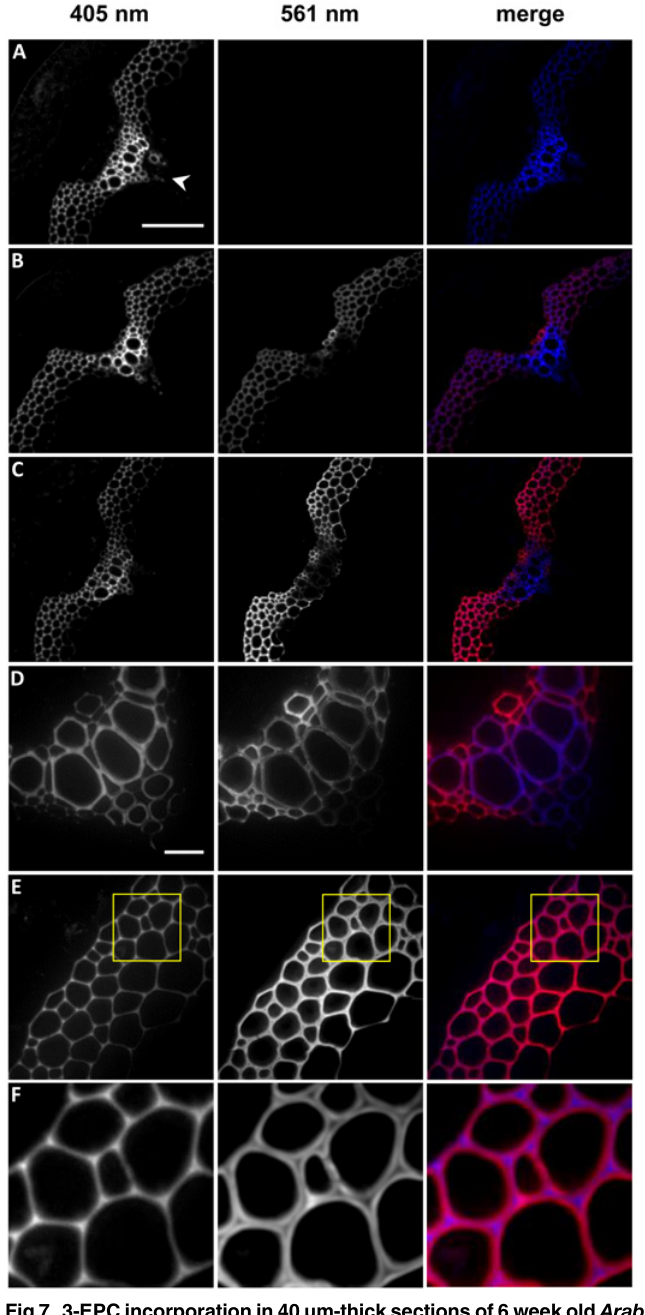
Fig 7. 3-EPC incorporation in 40 μ m-thick sections of 6 week old Arabidopsis stems. Autofluorescence (405 nm excitation) and click labeling (561 nm excitation) in (A) control section treated with 20 μ M CA for 3 h, labeled with Alexa-594 azide for 1 h, and washed with 96% ethanol for 1 h; (B) section treated with 20 μ M 3-EPC and 20 μ M CA for 3 h, labeled with Alexa-594 azide for 1 h, and washed with 96% ethanol for 1 h; and (C) section treated with 20 μ M 3-EPC for 3 h, labeled with Alexa-594 azide for 1 h, and washed with 96% ethanol for 1 h. (D) Xylem and (E) interfascicular fibers (IFFs) of section treated with 20 μ M 3-EPC. (F) Zoomed-in region from image in (E), indicted by yellow box, showing incorporation patterns of 3-EPC in IFFs. Arrowhead in (A) indicates vascular bundle, with interfascicular fibers lying on either side. Images are contrast-enhanced maximum intensity projections of z series recorded with a spinning disk fluorescence confocal microscope. (A-C) were recorded using a 20X objective with a 561 nm laser at 15% power, 100